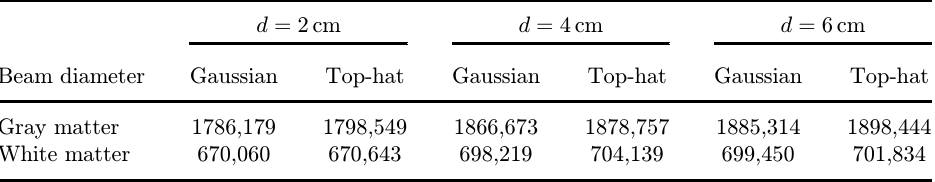
Table 4. Mean numbers of light penetrated voxels within brain tissue. Std < 0 : 01 %Mean .